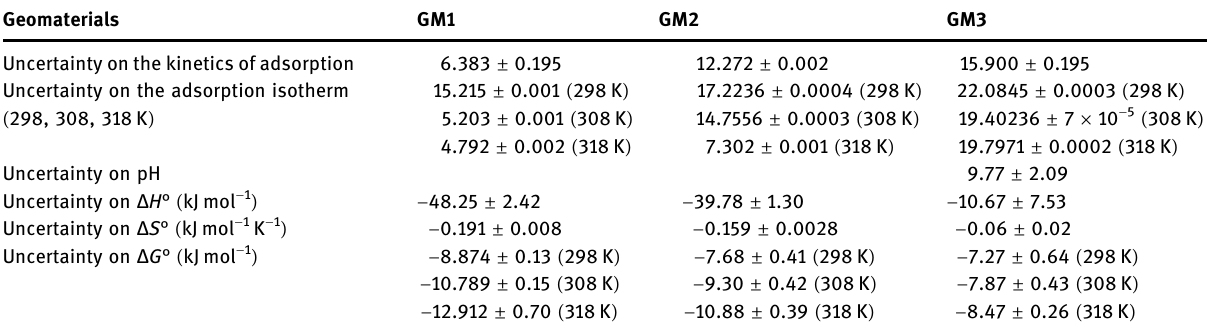
Table 4: Error calculation on paracetamol adsorption study on geomaterials GM1, GM2, and GM3